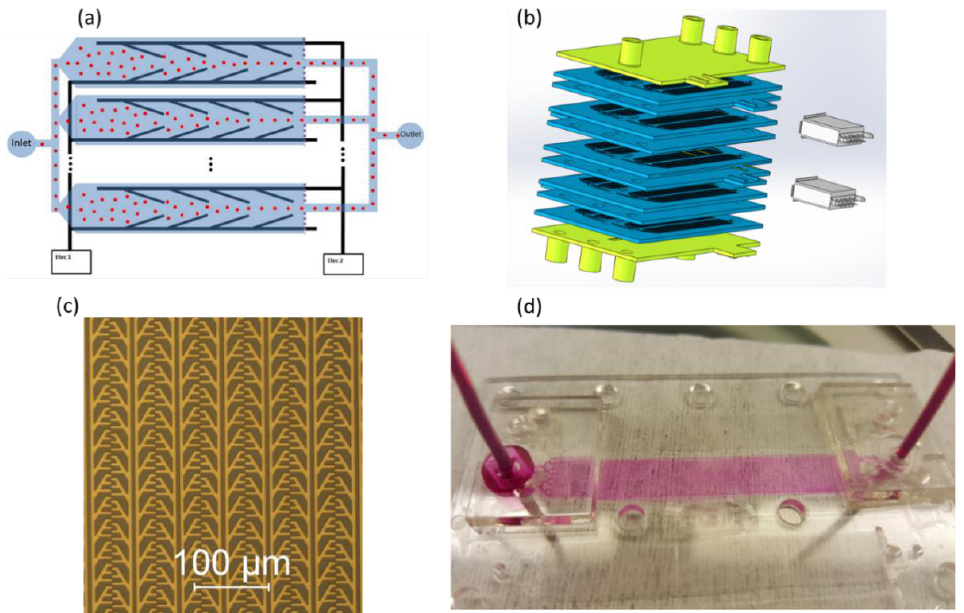
Figure 12. ( a ) A schematic of the parallelization concept. Only two electrodes provide voltage on all electrode pairs for an arbitrarily large number of parallel channels. All particle outlets are connected together in the chip plane, while all side outlets exit the chip from a common outlet in the bottom (not drawn). ( b ) A 3D drawing of the full chip, containing vertically stacked units, each containing 128 parallel channels. The dimensions of each chip are 65 mm × 48 mm. ( c ) Multiple electrode pairs fabricated by photolithography as described above. In this image, 6 parallel channels are shown. ( d ) A flow test of the microfluidic part of the device. For testing purposes, every 32 parallel channels were grouped together with one common inlet and outlet.